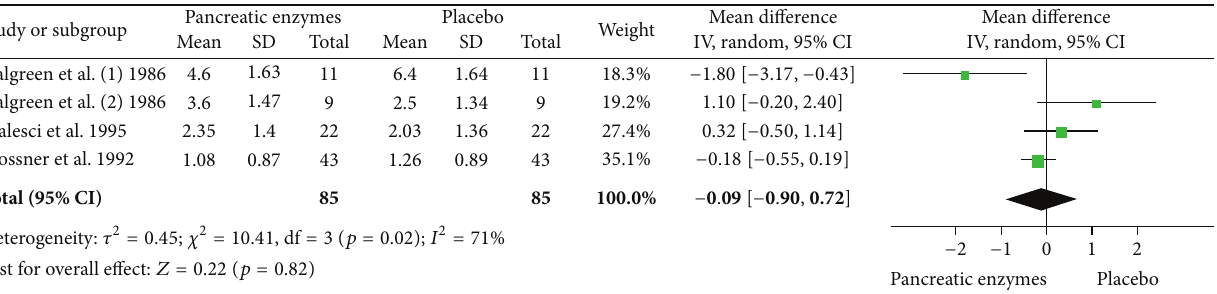
Figure 4: Random model meta-analysis of the mean of daily pain score in two crossover studies ( 𝑛 = 42 ).